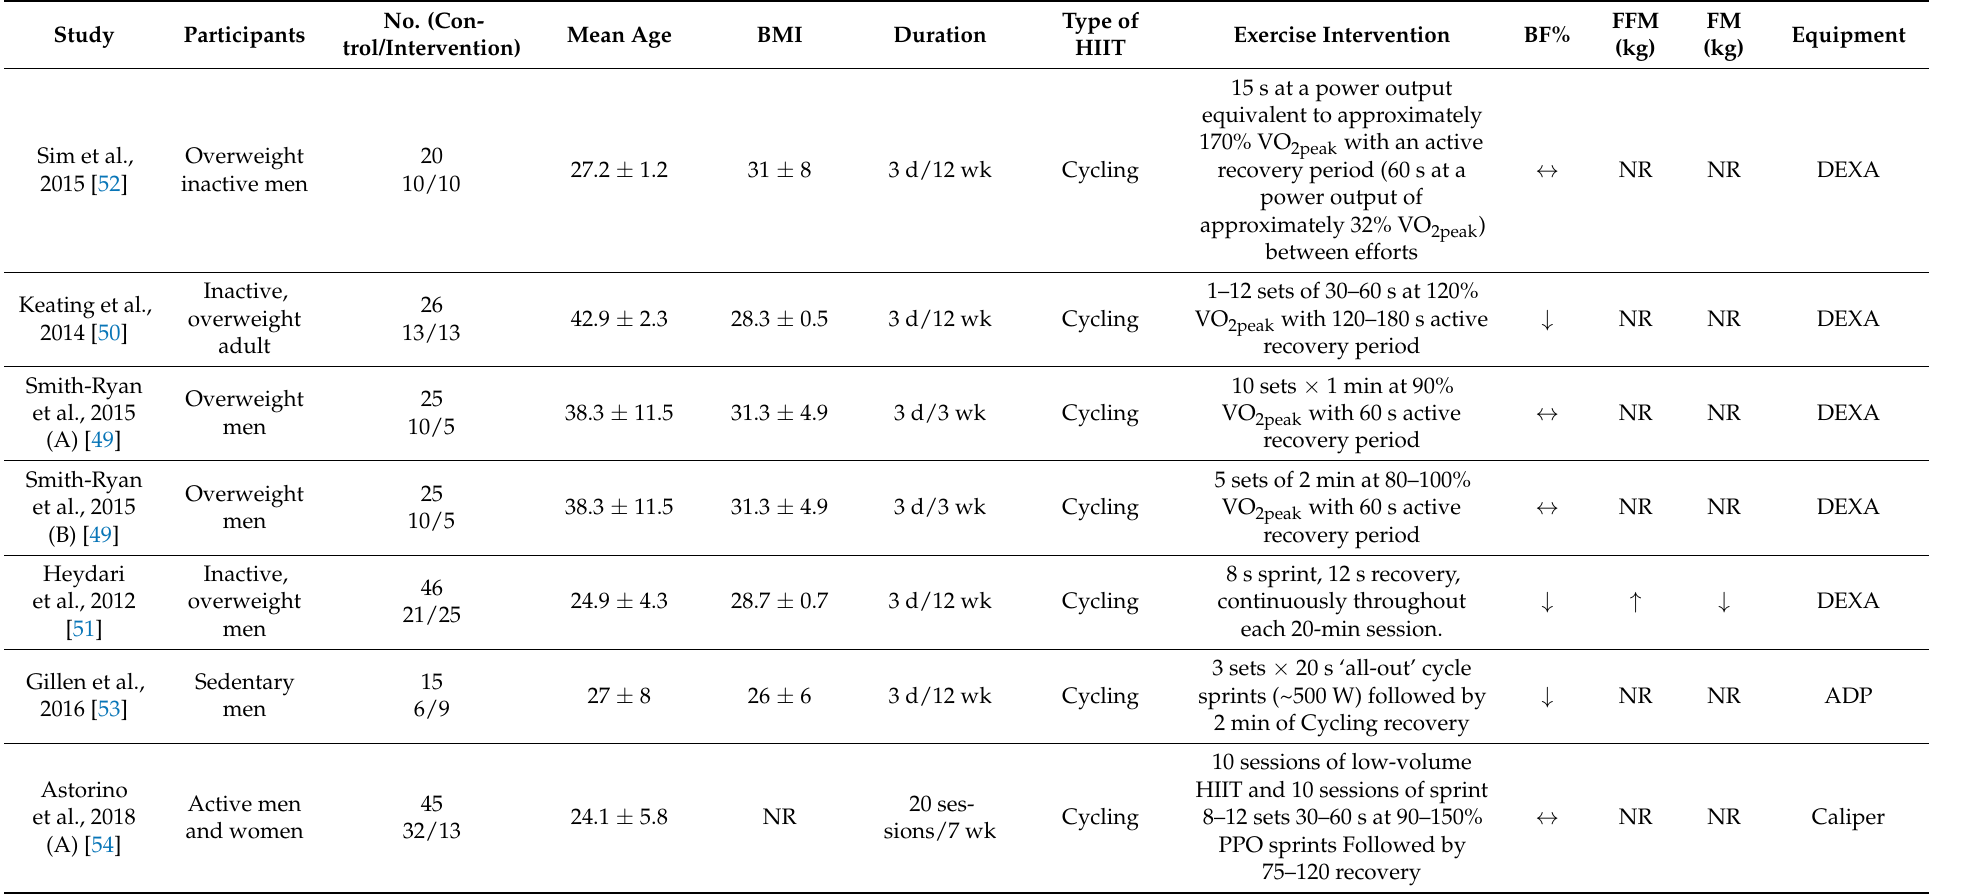
Table 2. Characteristics of the RCTs included in the current systematic review and